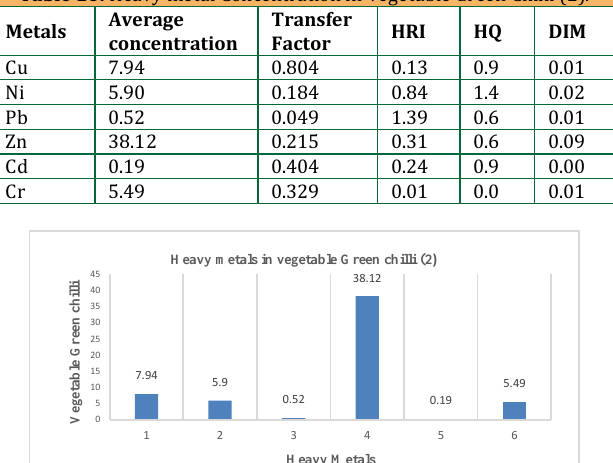
Table 16: Heavy metal Concentration in Vegetable Green Chilli (2).